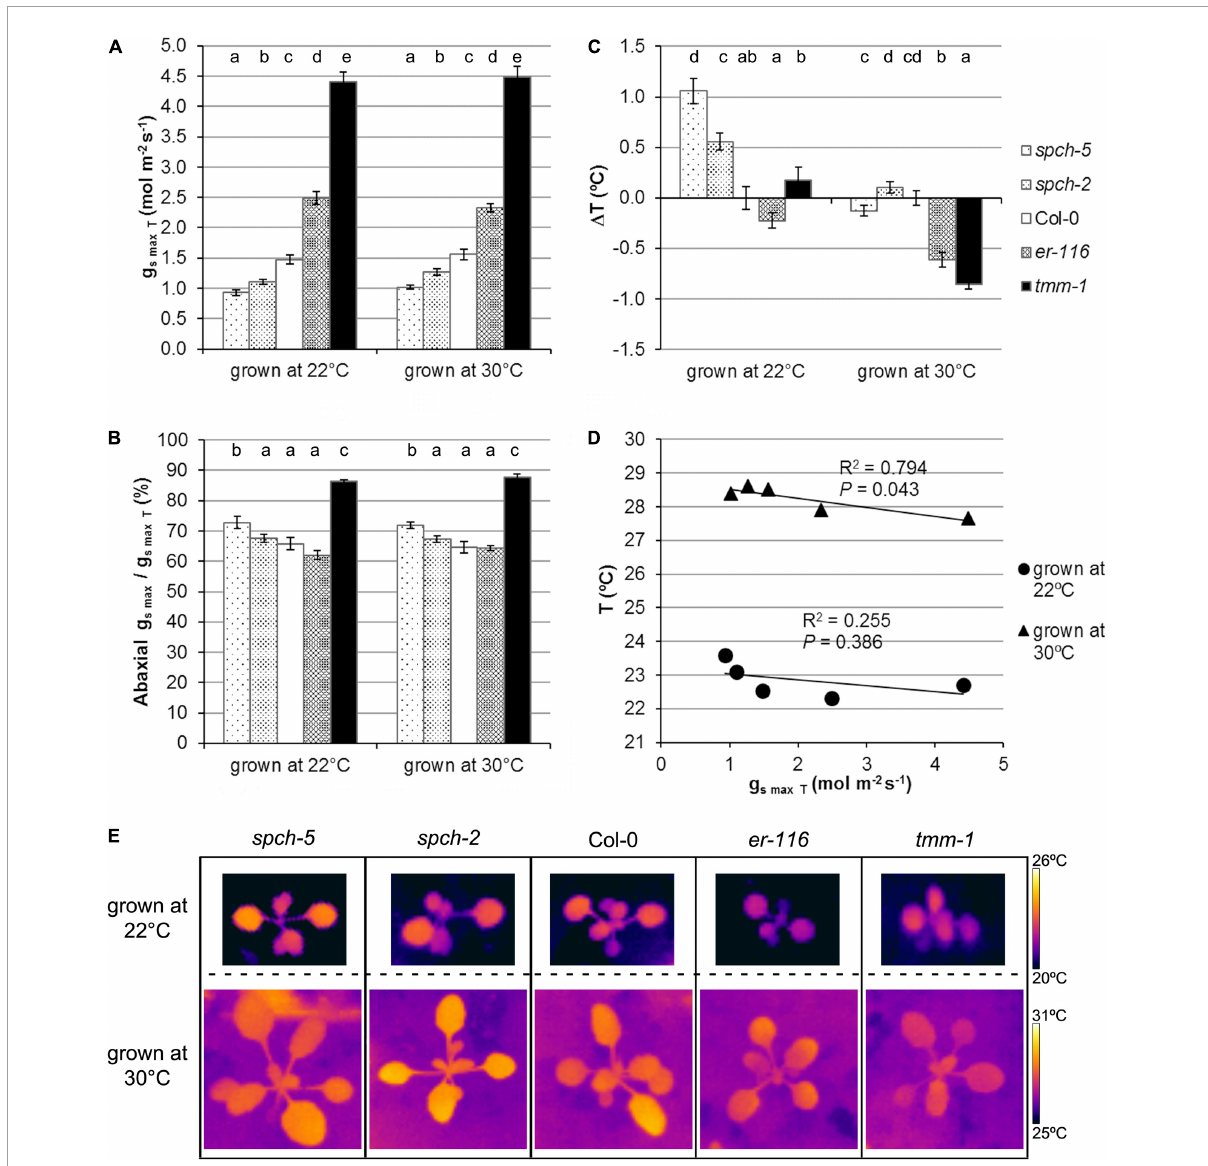
FIGURE5 Stomatal conductance under optimal and supra-optimal growth temperature. (A) Calculated total g smax for the leaf, (B) the fraction contributed by the abaxial g smax for fully expanded leaves, and (C) alteration in leaf temperature relative to the wild type. Values are means ± SE, calculated from n = 7 (A,B) and n = 20 (C) . Different letters above the bars indicate statistically significant differences between genotypes at the same growth temperature ( p ≤ 0.05) according to the Kruskal–Wallis test followed by the Dunn’s test. (D) Relationship between leaf temperature and the total g smax . The mean values of each genotype at a given growth temperature were used for the regression analysis. (E) Thermographic images of whole plants at 15